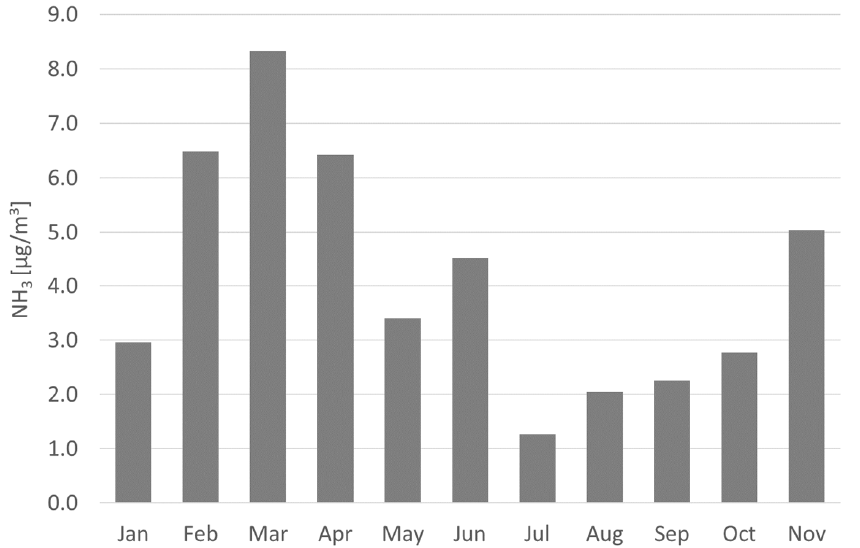
Figure 9. Derived background concentrations for ammonia on a monthly mean basis for the entire observational period from January to November